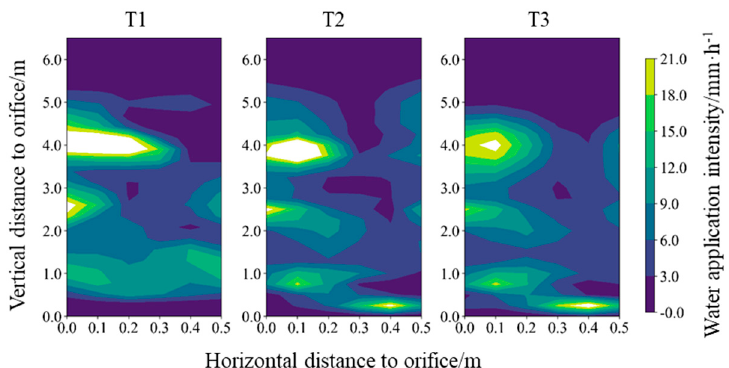
Figure 10. Water application intensity of single-sided micro-sprinkling hose composed of odd-numbered individual orifices in different test modes: T1 was the measured value, T2 was the fitting value by overlapping the measured water application intensity of multiple individual orifices and T3 was fitting value with the overlapping and bimodal two-dimensional Gaussian distribution model of multiple individual orifices.